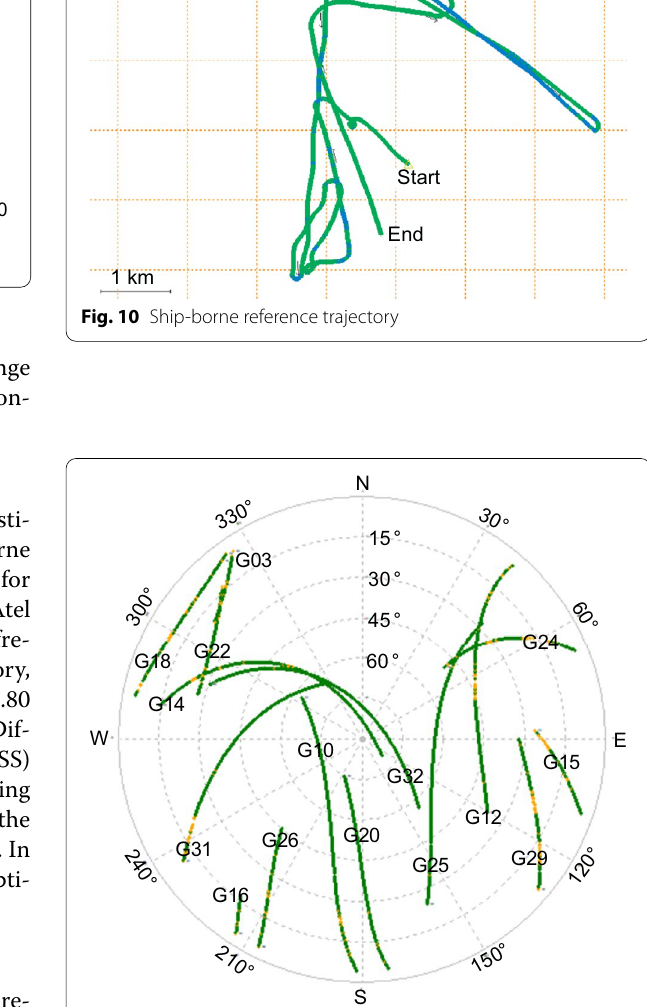
Results of scheme2 (optimal) Results of scheme3 (real-time)